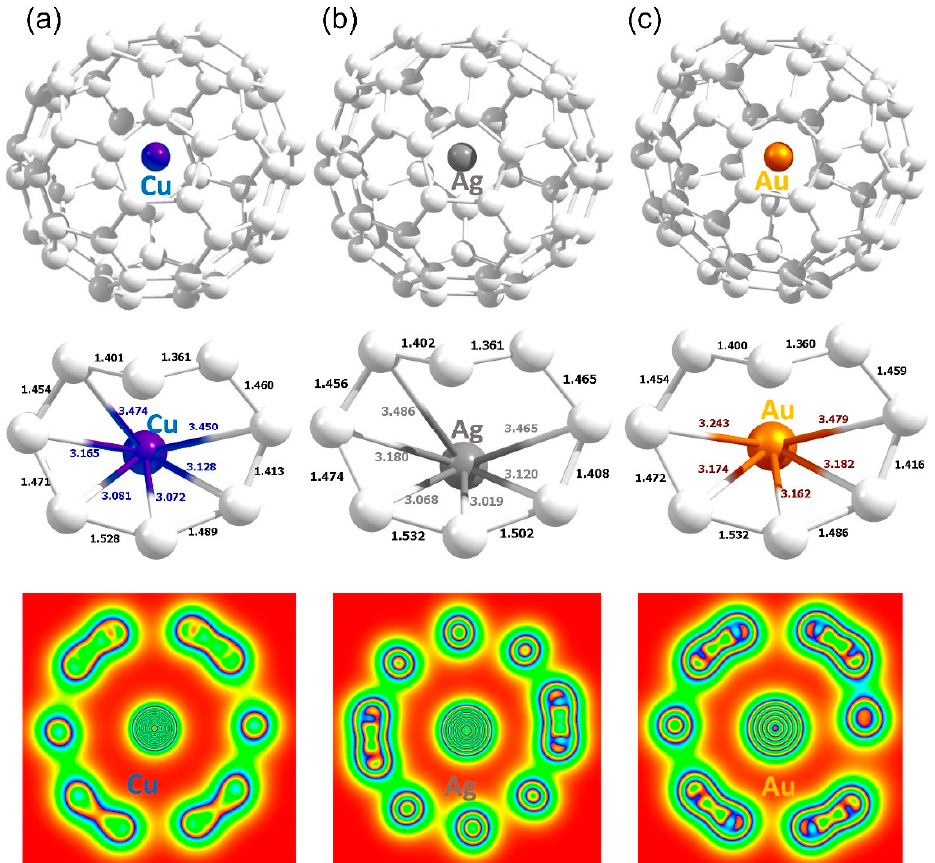
Table 5. Encapsulation energies, Bader charge on the metal atoms and magnetic moments of the endohedral composites formed between the defective C 60 molecule and metals.